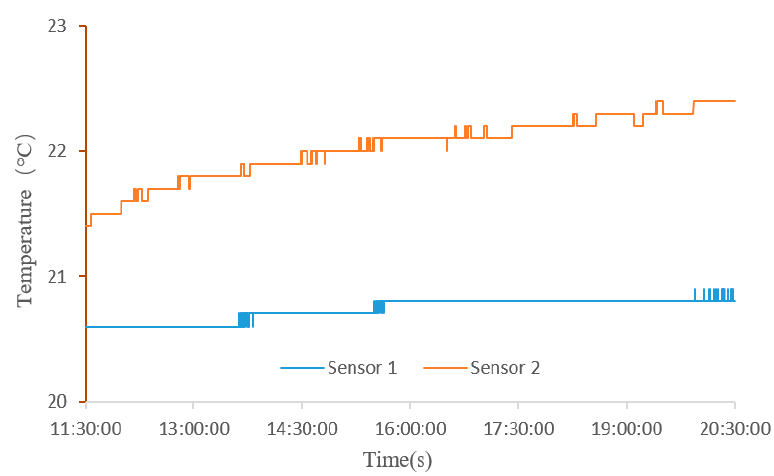
Figure 8. The temperature changes at the measurement locations the concrete foundation.